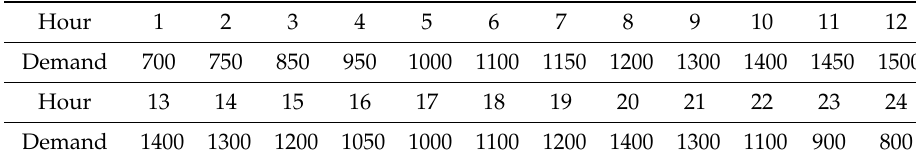
Table 7. 24-hour load demand for 10-unit system.